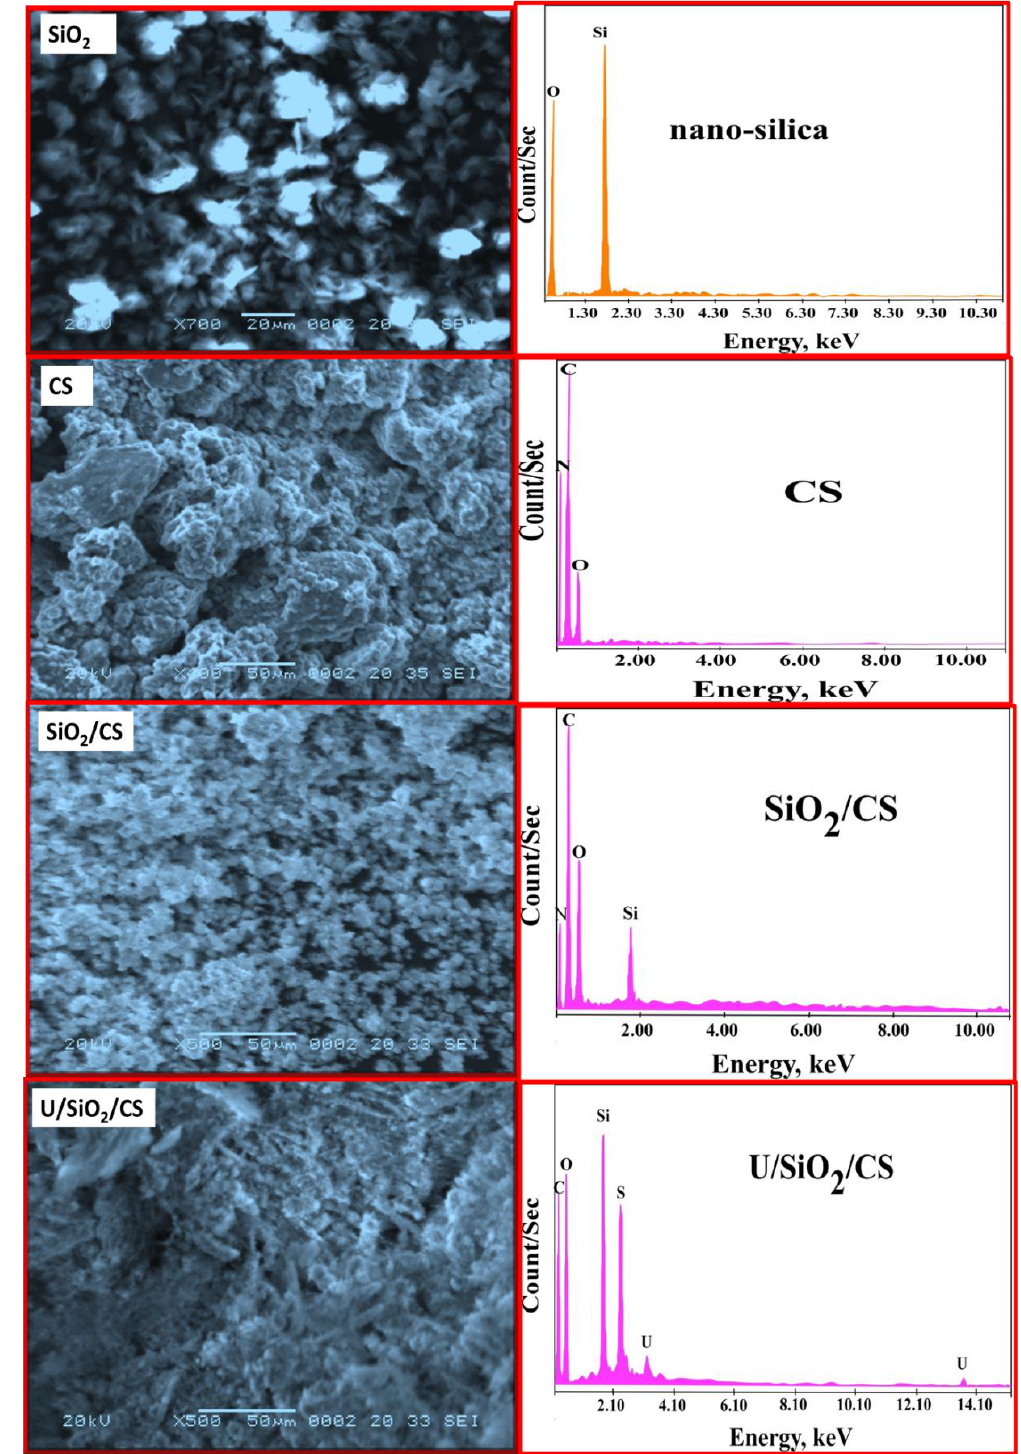
Figure 2. SEM and EDX photographs of SiO 2 , CS, SiO 2 /CS, and U/SiO 2 /CS.